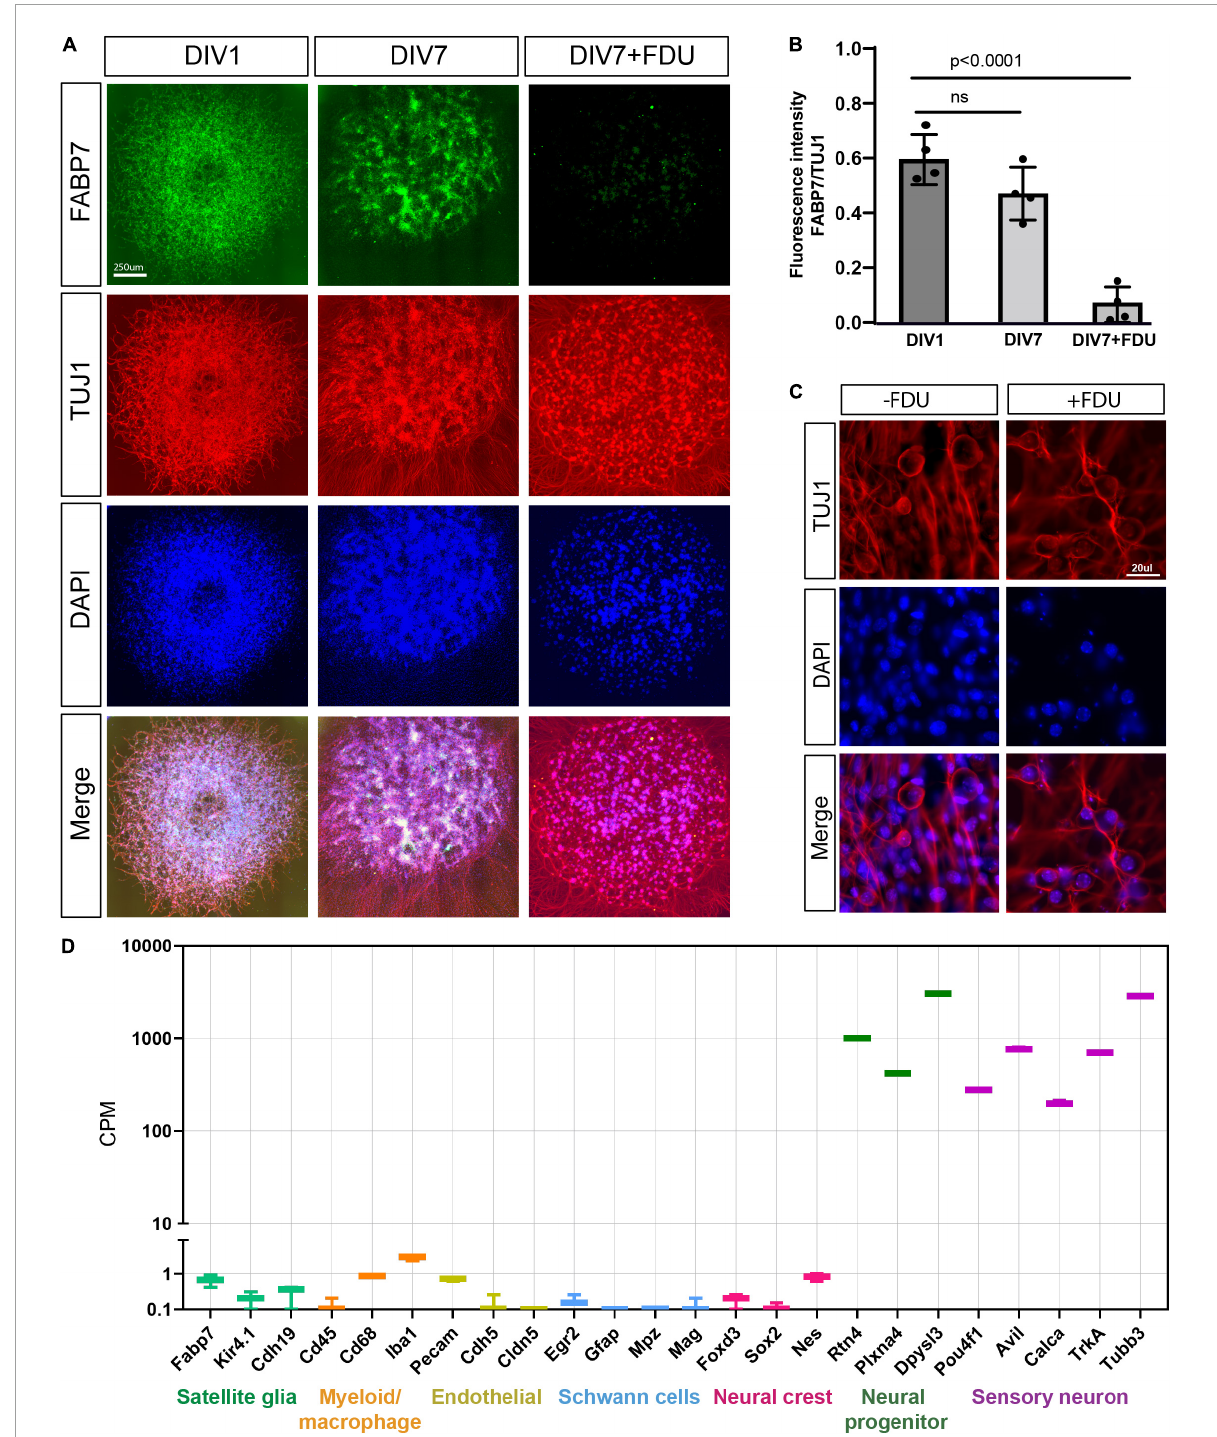
FIGURE1 eDRG spot culture contains mostly sensory neurons after treatment with FDU. (A) Representative images of eDRG culture stained with the neuronal marker TUJ1 (red) and the Satellite glia marker FABP7 (green) at DIV1 and at DIV7 with and without treatment with FDU. Scale Bar: 250 µ m. (B) Quantification of the fluorescence intensity of FABP7 normalized to TUJ1 at DIV1 and DIV7 ± FDU. n = 4 biologically independent animals. P values are determined by One way ANOVA. Data are presented as mean values ± SEM. (C) Representative images of eDRG culture in high magnification, with and without FDU, stained with TUJ1 (red) and DAPI (blue). Scale Bar: 20 µ m. (D) Quantification of selected neuronal and non-neuronal markers (counts per million) from RNAseq analysis of eDRG spot culture at DIV7 treated with